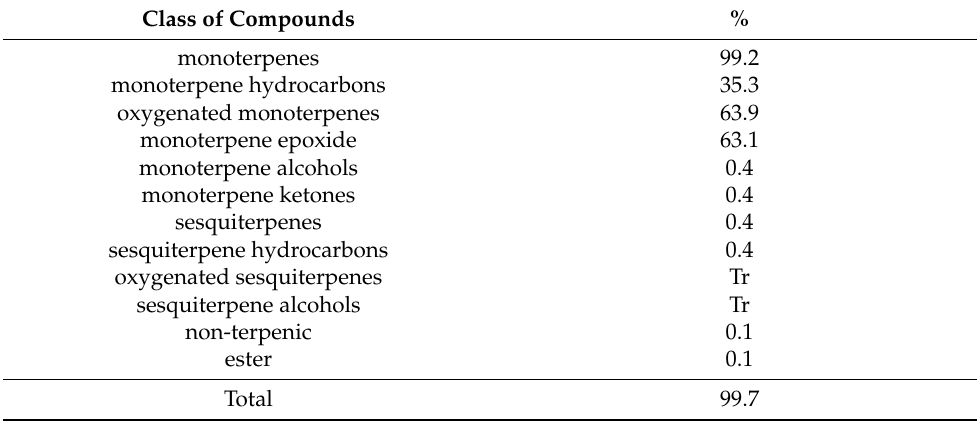
Table 2. The volatiles presented in percentage for each class of